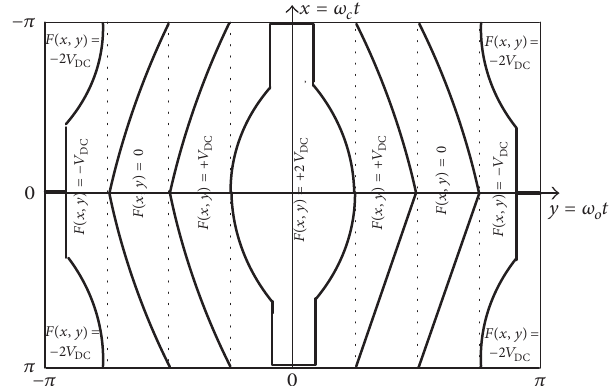
Figure 8: Contour plot of 𝐹(𝑥,𝑦) for five-level multilevel inverter.